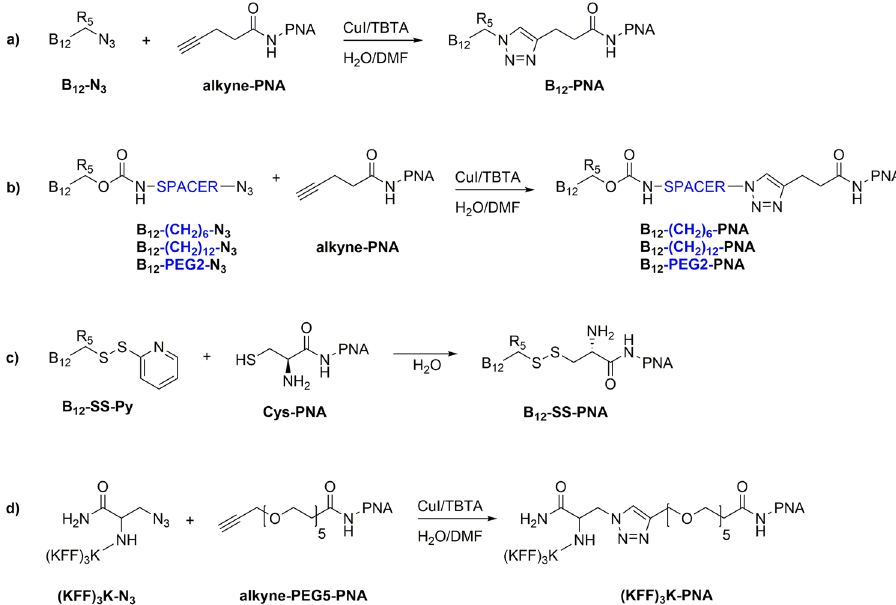
Figure 3. Synthesis of vitamin B 12 and (KFF) 3 K conjugates with PNA. The spacer is marked in blue.